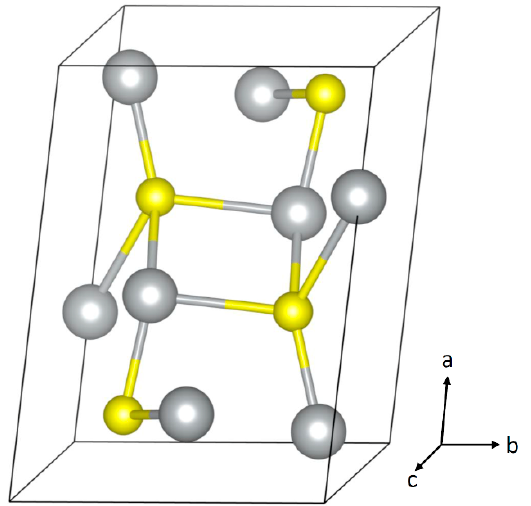
Figure 1. Pure silver sheet after exposure to ambient office and laboratory environments for a period of a couple of years (left) as compared to a couple of decades (right).